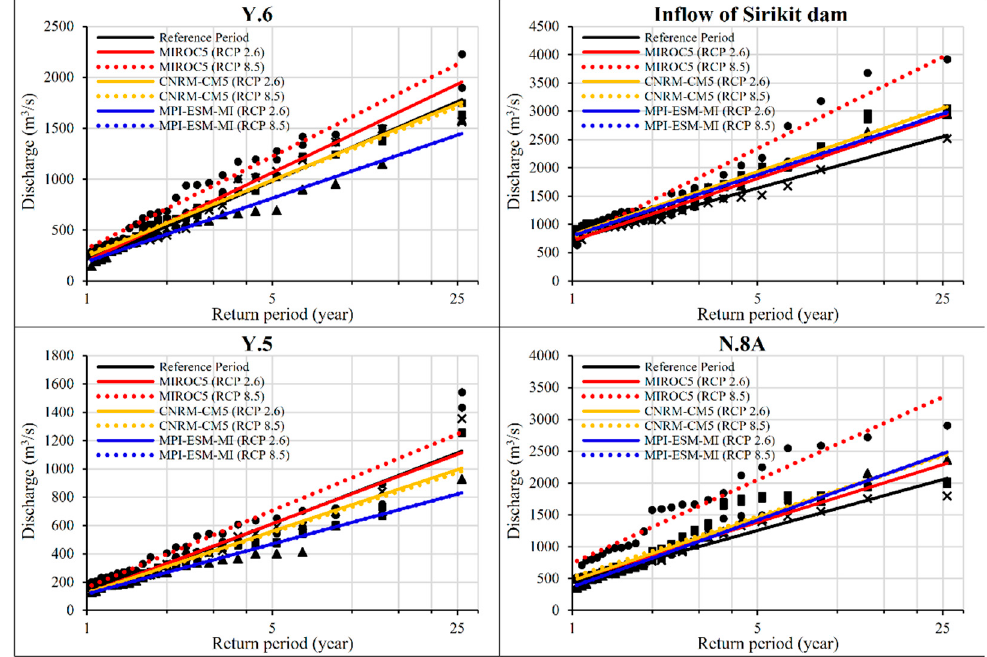
Figure 14. Return period of peak discharge in the far future (2071–2095) under scenarios RCP 2.6 and RCP 8.5 compared with the reference period.